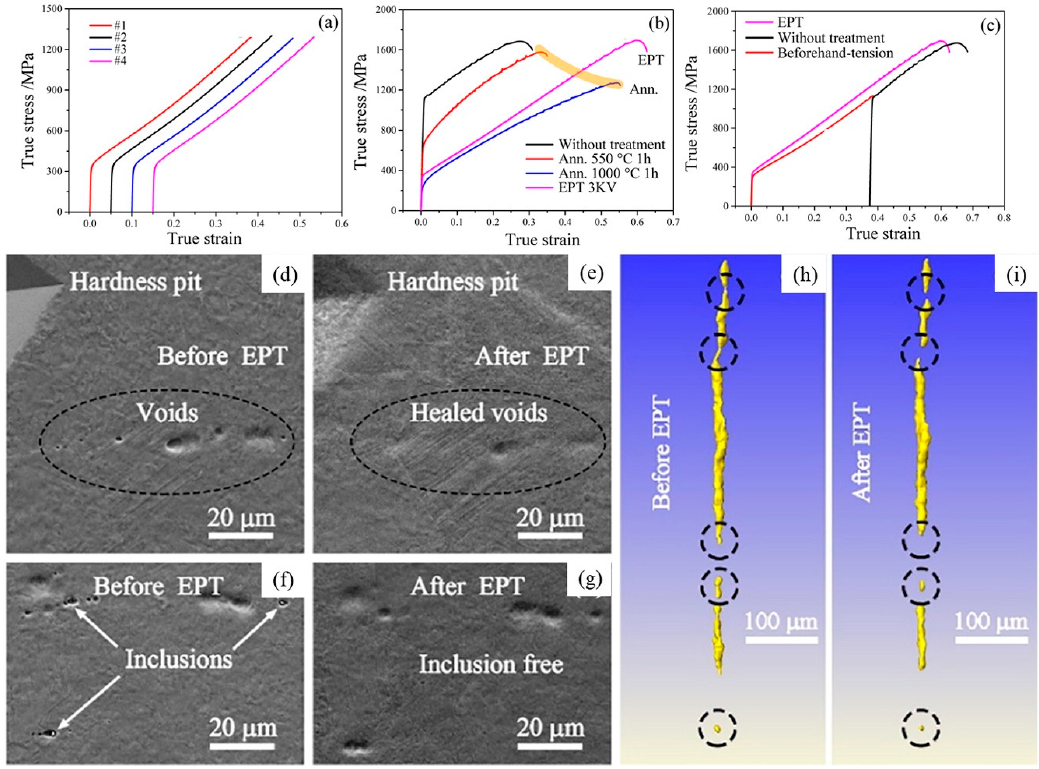
Figure 6. ( a – c ) tensile results, ( d – g ) SEM images, and ( h – i ) XRT volume renderings of a crack for